Question: What style of plot is this figure drawn as?
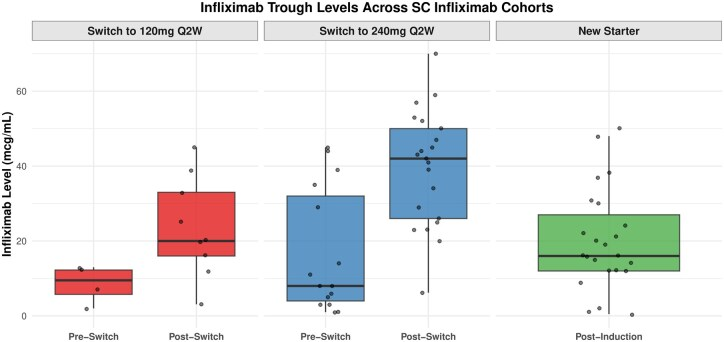
Answer: box